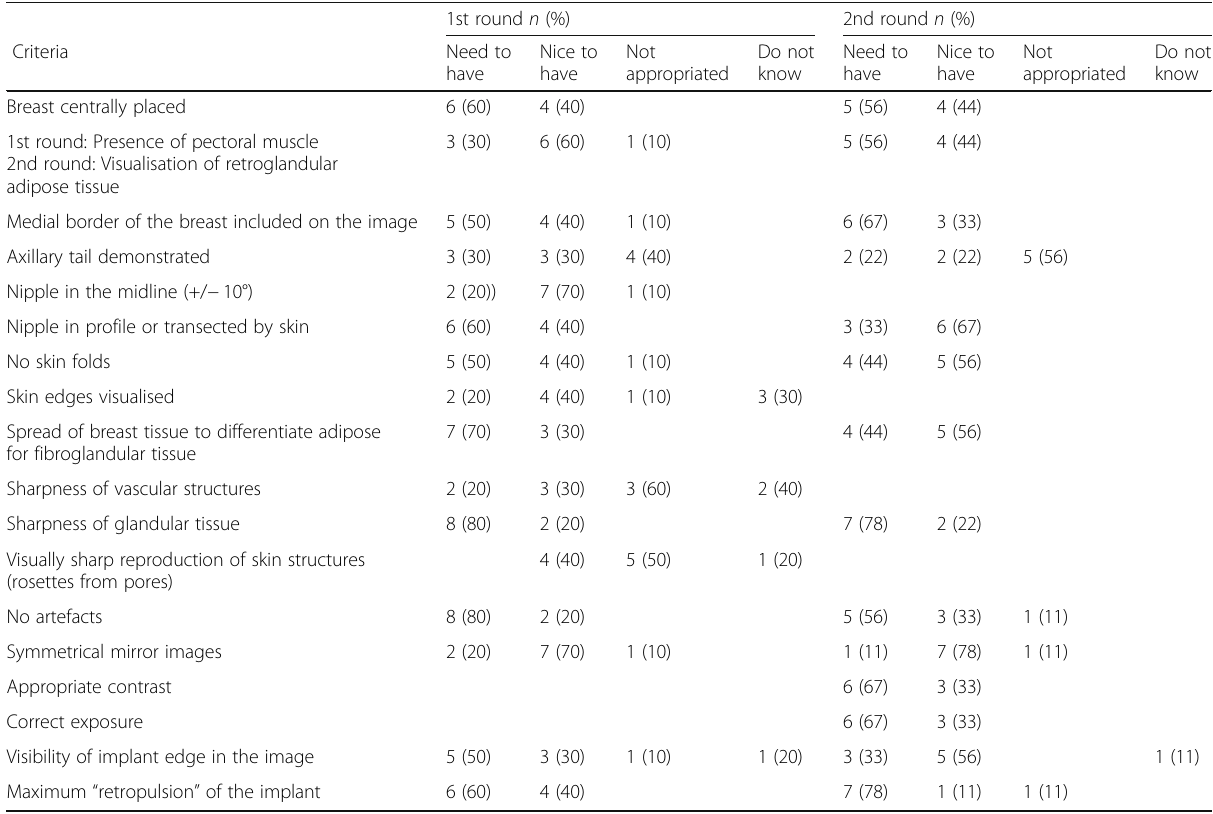
1st round n (%) 2nd round n (%) Nice to Not Do not have have appropriated know 3 (30) 6 (60)